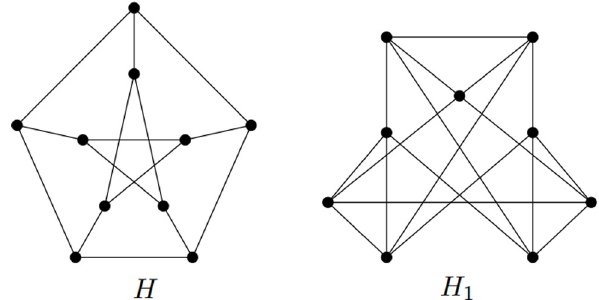
Figure 1: Graphs with three distinct AG -